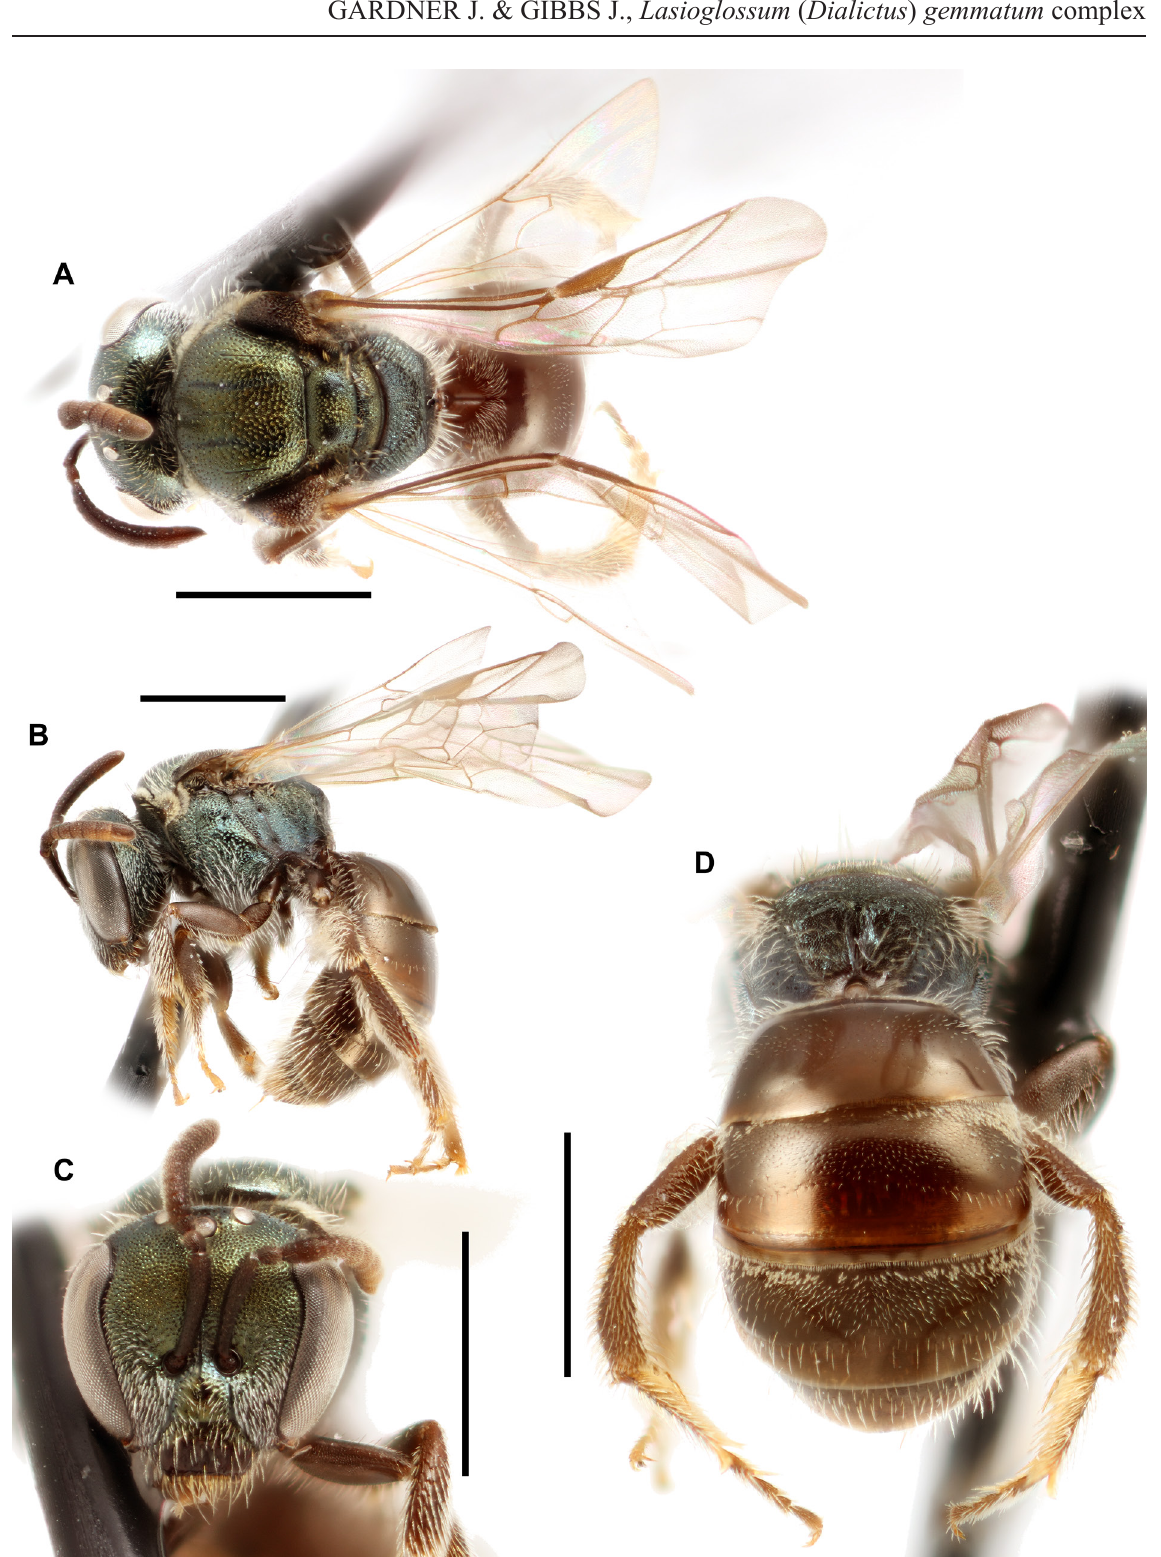
Fig. 42. Lasioglossum ( D .) magnitegula sp. nov., ♀, holotype (BBSL FDP746586). A . Dorsal habitus. B . Lateral habitus. C . Face. D . Metasoma and propodeum. Scale bars = 1